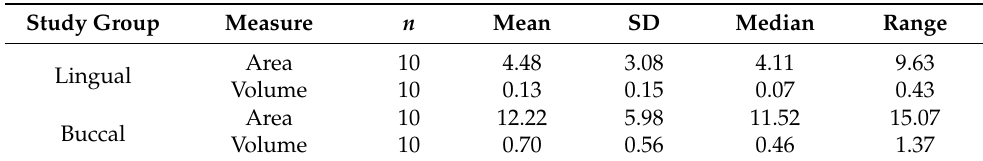
SD: Standard deviation. Table 2. Descriptive statistics of the area (mm 2 ) and volume (mm 3 ) of remaining cement after cement polishing of the lingual and buccal multibracket appliance therapies.